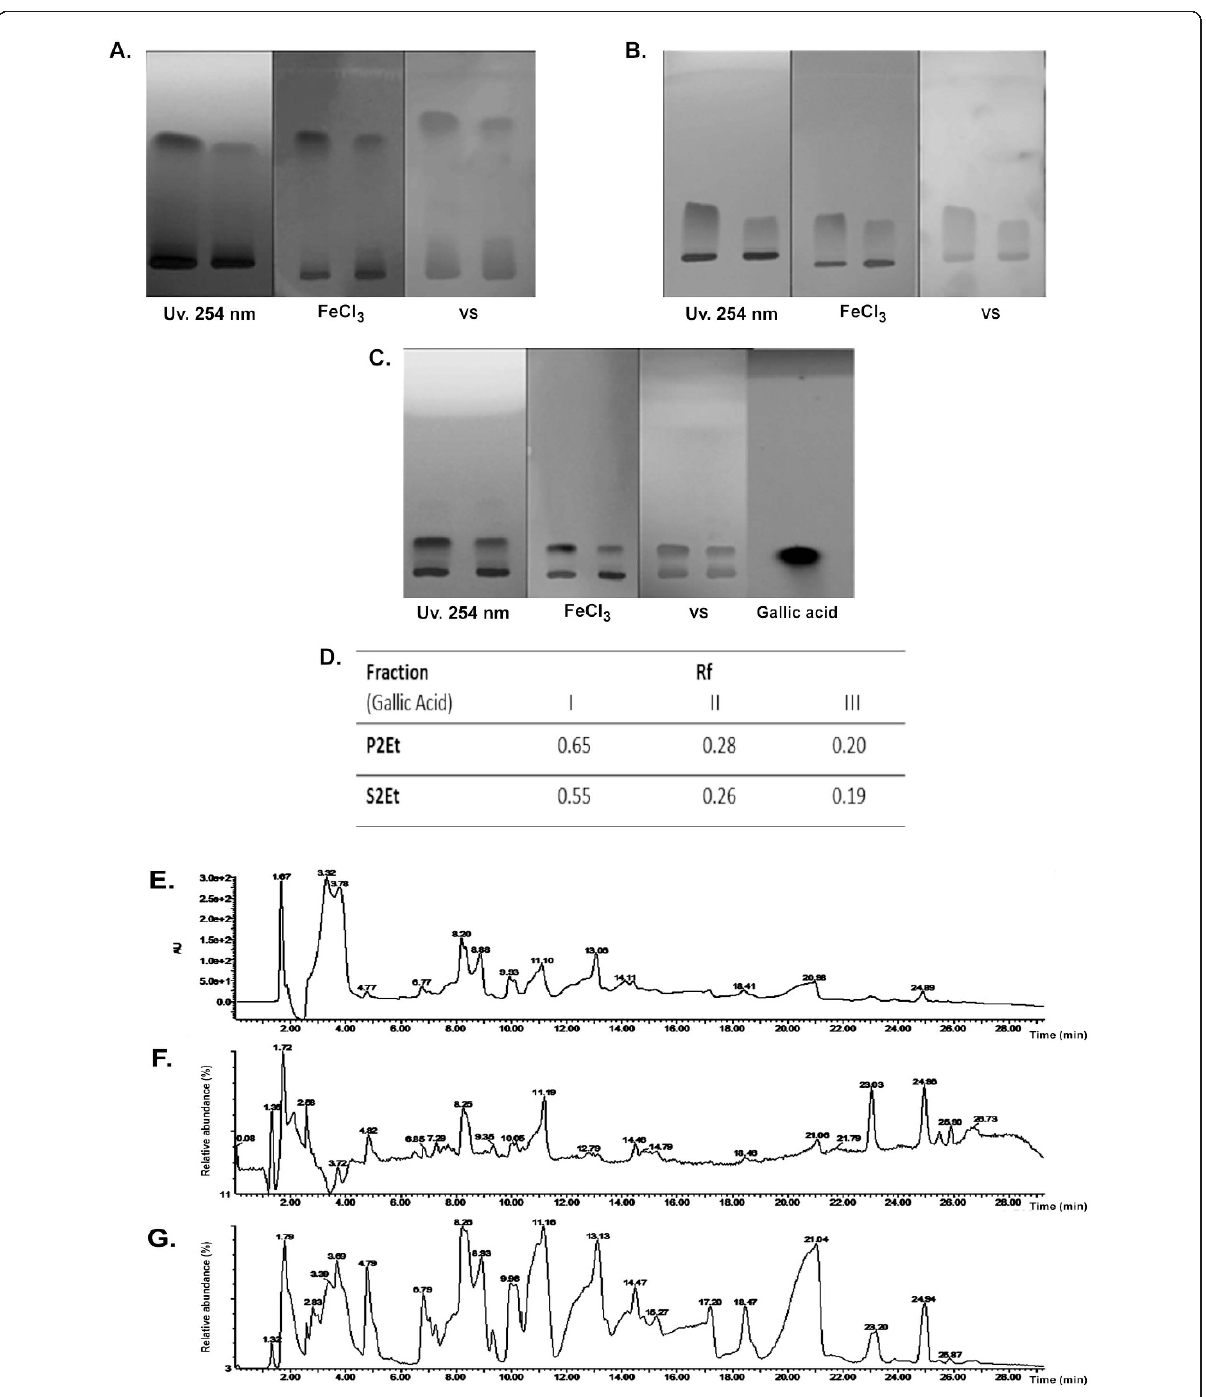
Figure 1 P2Et fraction thin layer chromatographic profile . (A) Solvent I: petroleum benzene - ethyl acetate - formic acid (40:60:1). (B) Solvent II: chloroform - ethyl acetate - acetic acid (50:50:1). (C) Solvent III: Toluene - acetonitrile - formic acid (70:30:1). Lane 1: P2Et fraction basic hydrolysis products. Lane 2: S2Et fraction basic hydrolysis products. TLC visualization with UV, 254 nm, ferric chloride (FeCl 3 ) and vanillin/sulfuric acid (VS) sprays. Gallic acid is a positive control. (D) Gallic acid Rf values in different solvent systems. (E) HPLC chromatogram at 263 nm. (F) MS spectrum positive mode. (G) MS spectrum negative